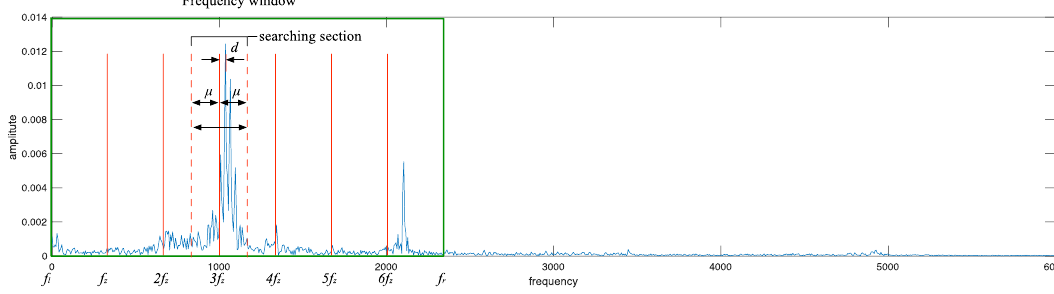
Figure 1. Sketch map of parameters in adaptive spectrum analysis.